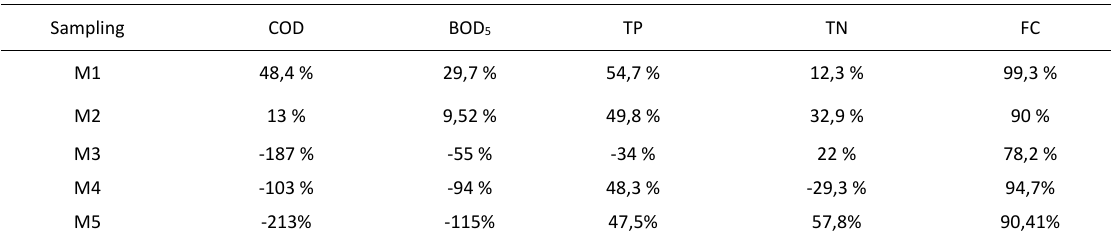
Table 2: Percentage of removal of physicochemical and microbiological Sampling COD